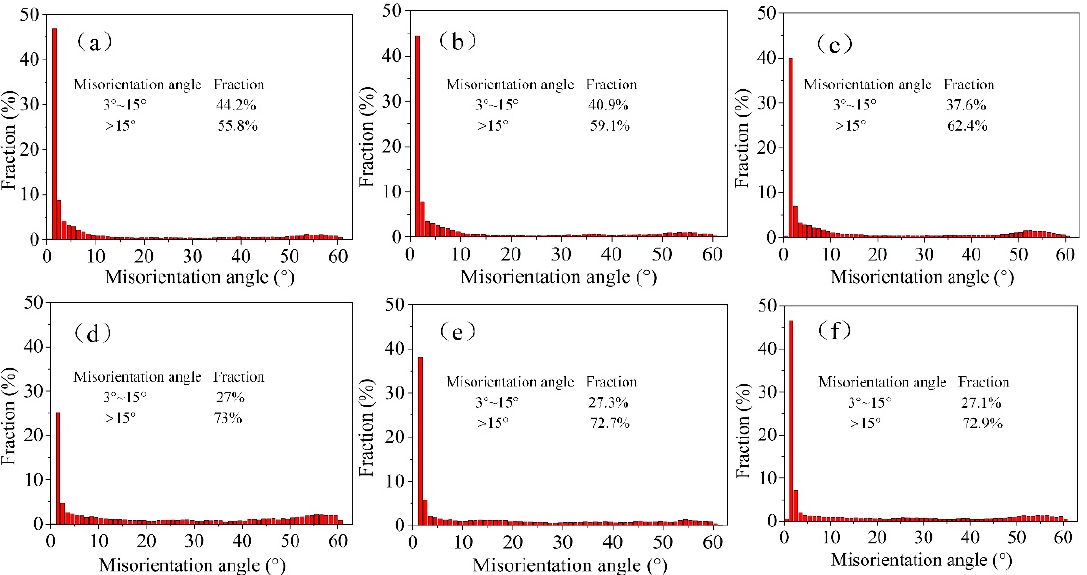
Figure 9. Misorientation angle distribution of rolled samples with thicknesses of ( a ) 600 µ m, ( b ) 400 µ m, ( c ) 200 µ m, ( d ) 80 µ m, ( e ) 40 µ m, ( f ) 20 µ Table 2. Data for rolled pure Cu without intermediate annealing.